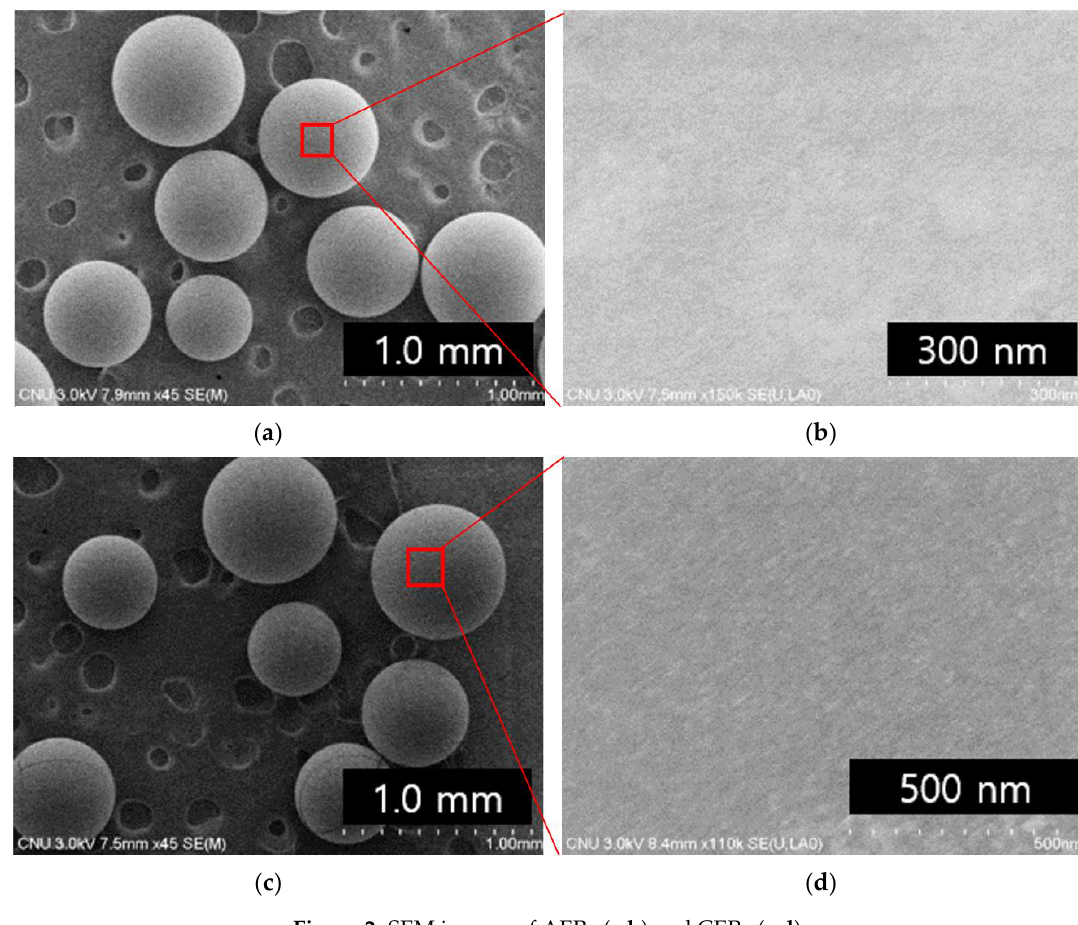
Figure 2 . SEM images of AERs ( a , b ) and CERs ( c , d ).